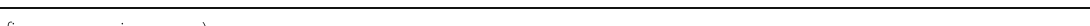
(See figure on previous page.) Fig. 6 45-year-old female with history of left breast cancer managed by lumpectomy on follow-up. Mammogram showed focal asymmetry at left UIQ and ultrasound revealed dilated ducts with thickened irregular wall. CE-MRI breast ( a ) axial T1 (to the left) and axial STIR (to the right) showed dilated ducts at left UIQ (white arrows). b Axial contrast T1 fat saturation showed suspicious looking clumped non-mass enhancement of segmental distribution at left UIQ with no detected mass lesion. c Type I curve of dynamic enhancement. d DWI showed no restricted diffusion (ADC = 2 × 10 − 3 mm 2 /s). e FA map, FA = 0.28 (> 0.2) matching with malignancy. Final MRI diagnosis was suspicious non-mass enhancement (BIRADS 4c) for biopsy. f FNC (to the left) showed groups of malignant pleomorphic ductal cells (arrows) and a core biopsy (to the right) showed malignant glands infiltrating the stroma (arrows) (H&E × 100). Final diagnosis was recurrent